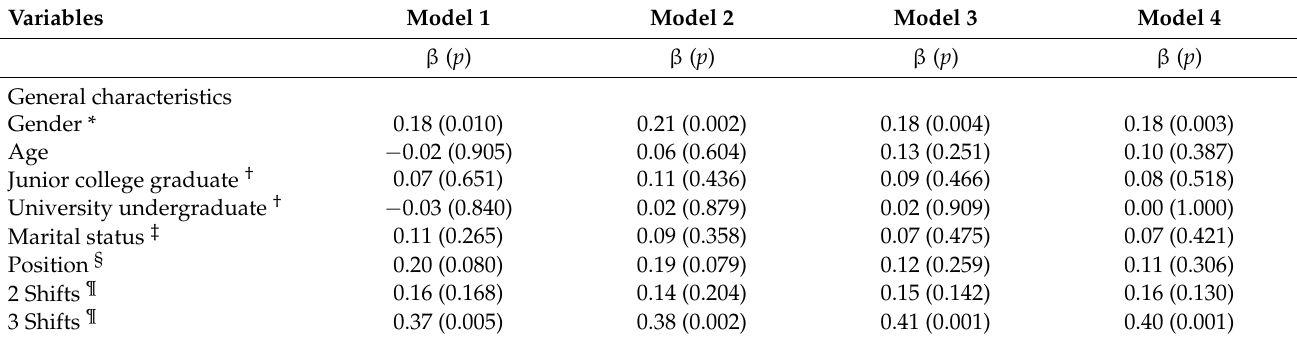
Table 4. Influencing factors on burnout of Korean clinical nurses ( n =